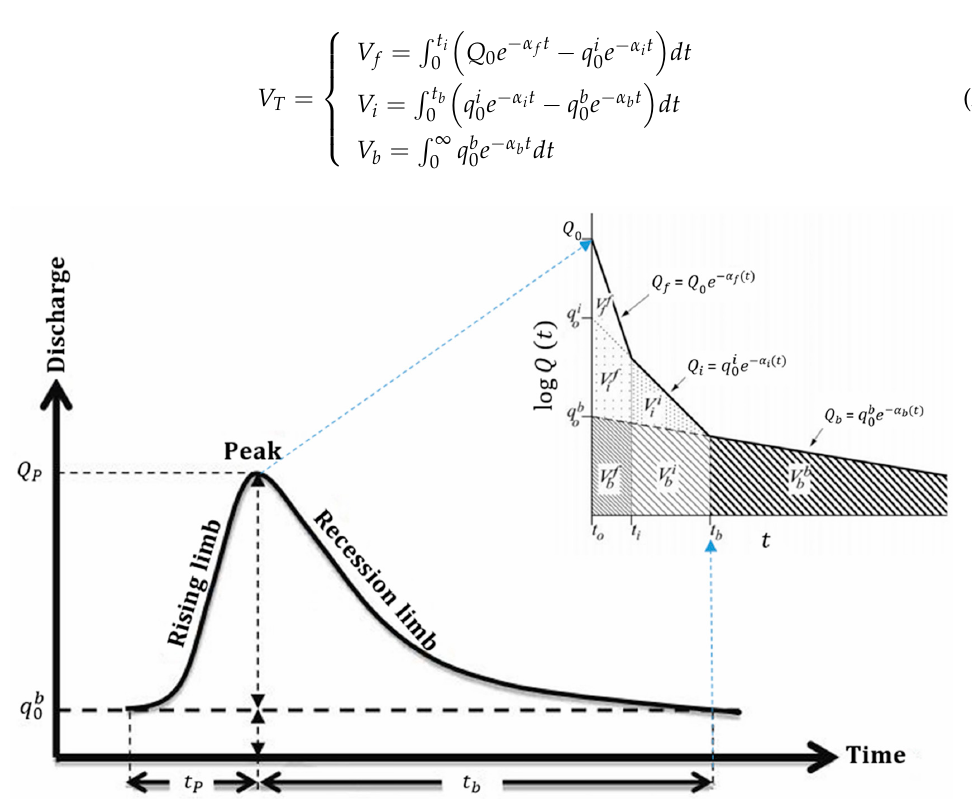
Figure 11. Schematic representation of karst spring hydrograph [49] and recession curve [47]. Q P is the peak discharge of spring, q b is the base discharge, t P is the time duration to reach the peak discharge, and t b represents the return time from the peak discharge to the baseflow. In the recession curve, Q or q is the flow rate, V is the discharge volume, α is the recession coefficient, and t is time. Index 0 indicative beginning points, and indices of f , i and b are the abbreviation of fast, intermediate, and baseflow, respectively.